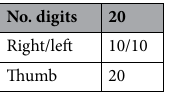
Table 1. General characteristics of digits.